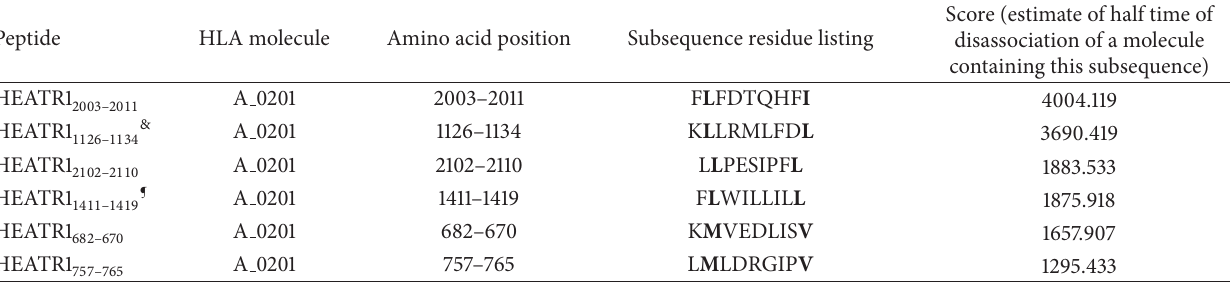
Score (estimate of half time